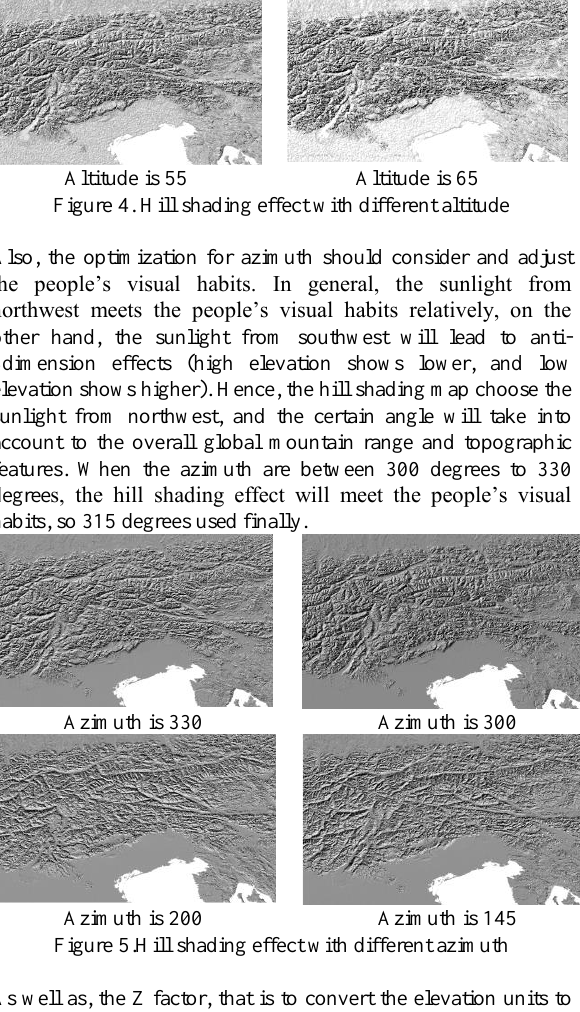
Figure 3 Satellite image and original terrian data